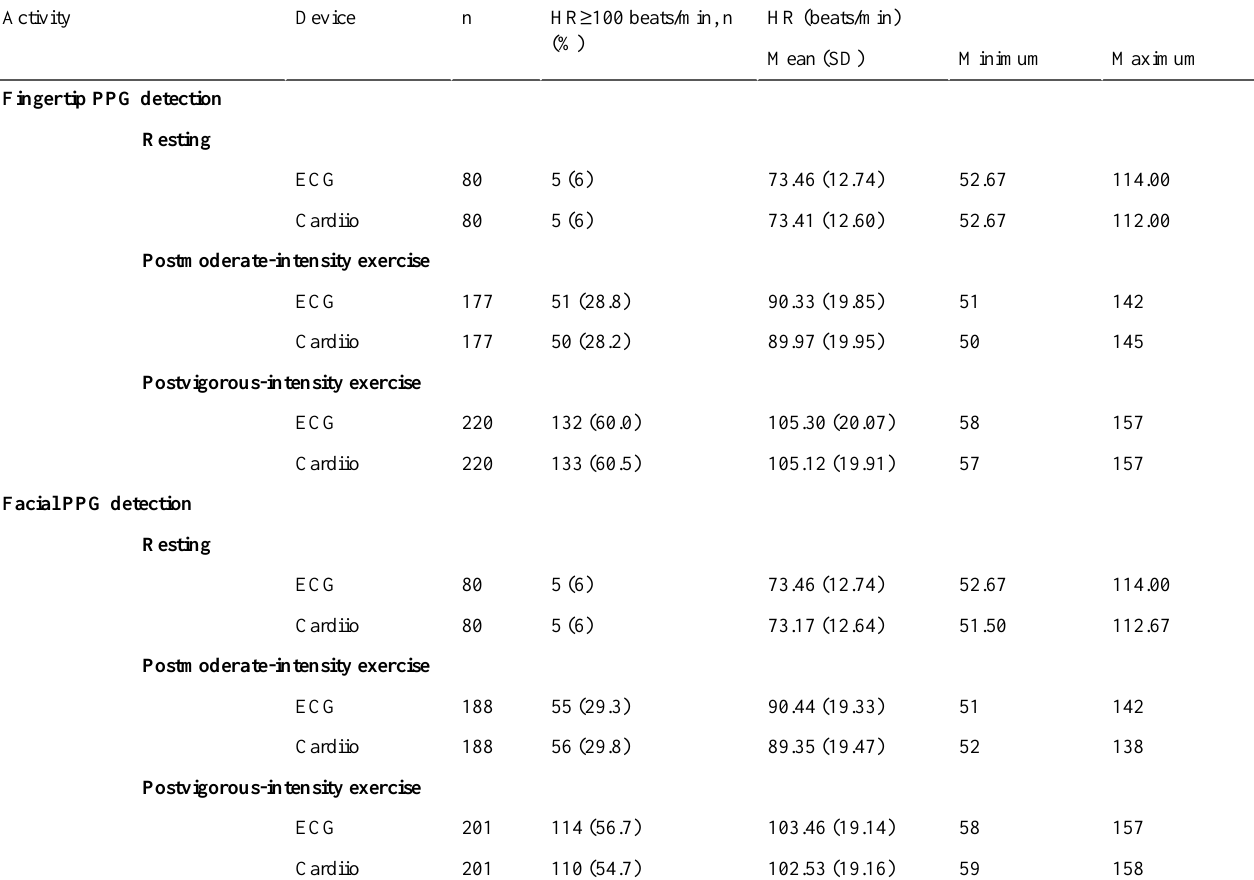
Table 2. Comparison of heart rates (HRs) measured by electrocardiogram (ECG), and fingertip and facial photoplethysmography